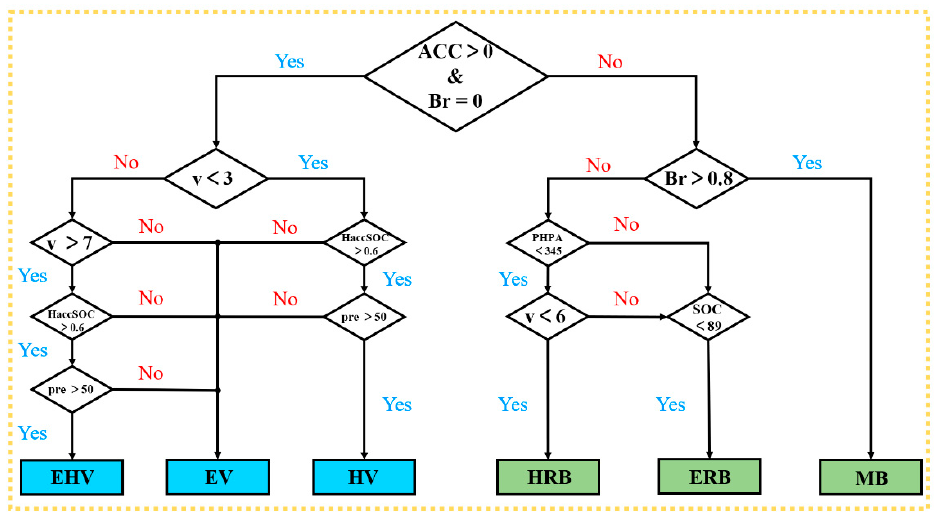
Figure 4. Logical control policy diagram.